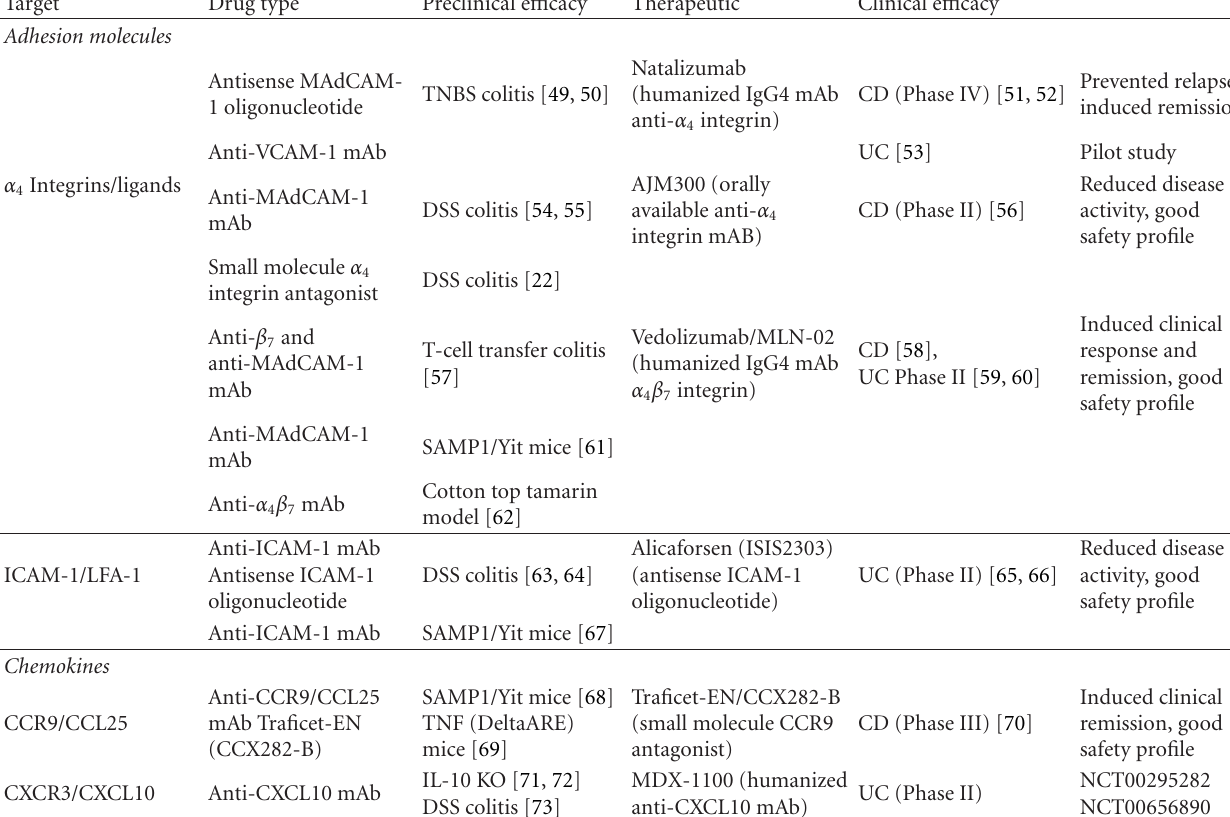
Table 1: Targeting leukocyte tra ffi cking in inflammatory bowel